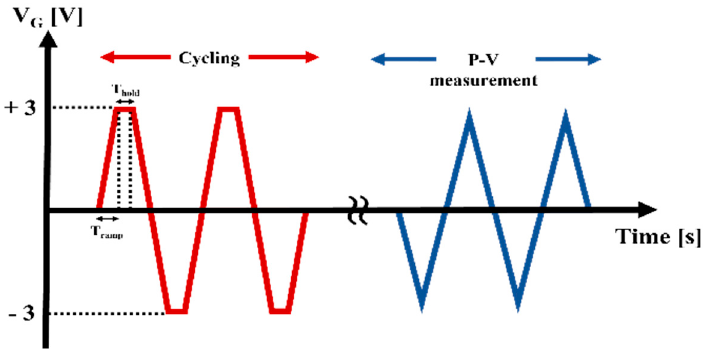
Figure 6. Illustrated pulsing scheme for analyzing the wake − up and fatigue behaviors of TiN/HZO/TiN capacitor. The cycling was first completed using the trapezoidal pulse with the ramp time (T ramp ) of 1 µs and the hold time (T hold ) of 1 µs. Afterwards, the P-V measurement was made using the triangular pulse. Note that the amplitude for both pulses is set to 3 V.